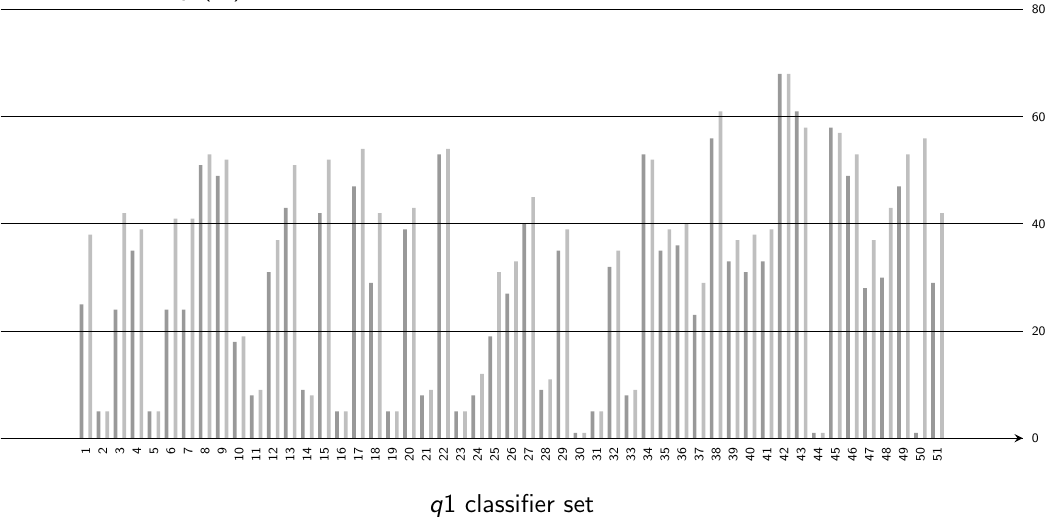
Figure 5. Accuracy for experiment 1, using the feature group c 1 and feature group c 2 . Labels in the horizontal axis associate the tested algorithms with its corresponding name in Table